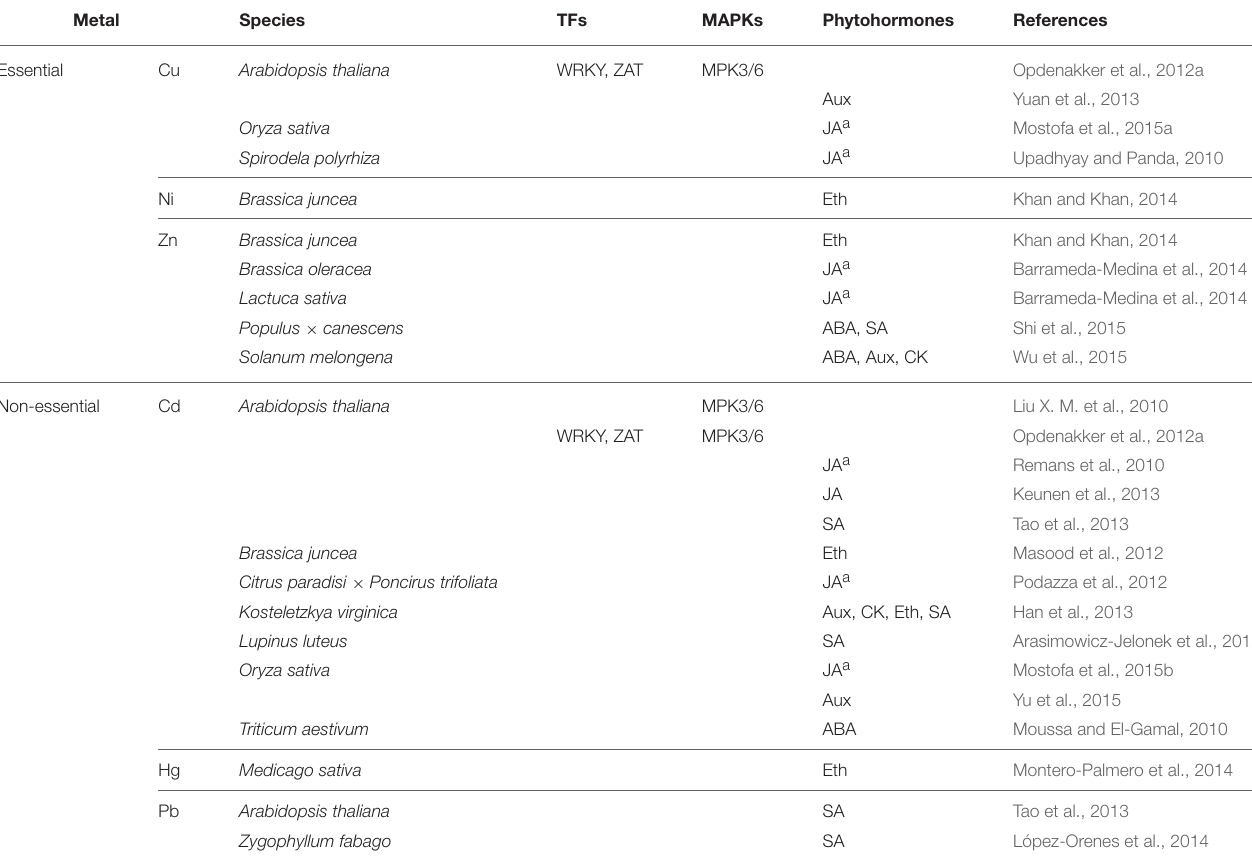
TABLE 3 | Signaling responses related to an elevated H 2 O 2 content induced by metal